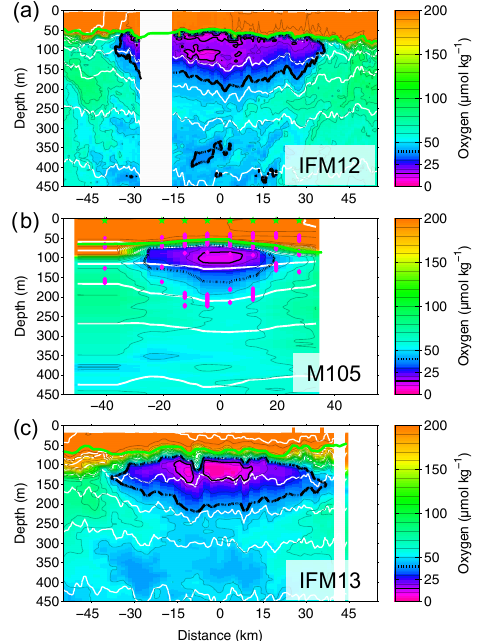
Figure 2. Oxygen distribution from the three eddy surveys (see Fig. 1) in reference to distance (0km is set at a subjectively se- lected eddy centre): (a) glider IFM12, (b) ship M105, and (c) glider IFM13. The 15µmolkg − 1 (40µmolkg − 1 ) oxygen contour is indi- cated as a bold (broken) black line. Selected density anomaly con- tours are shown as white lines ( (cid:49)σ = 0 . 2kgm − 3 ). The green line indicates the mixed layer base. The oxygen contour in (b) was grid- ded based on the eight CTD stations (locations indicated by the green stars at 0dbar) and mapped to a linear section in latitude, longitude. In (b) the magenta dots indicate positions of local N 2 maxima in the CTD